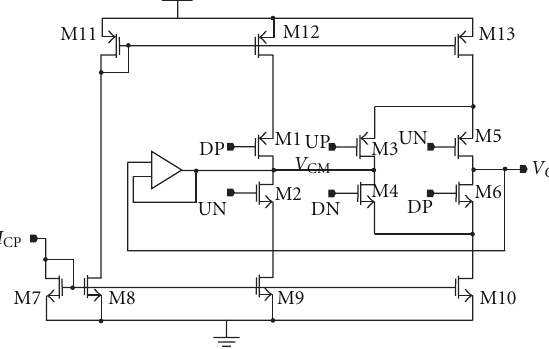
Figure 10: Circuit diagram of the